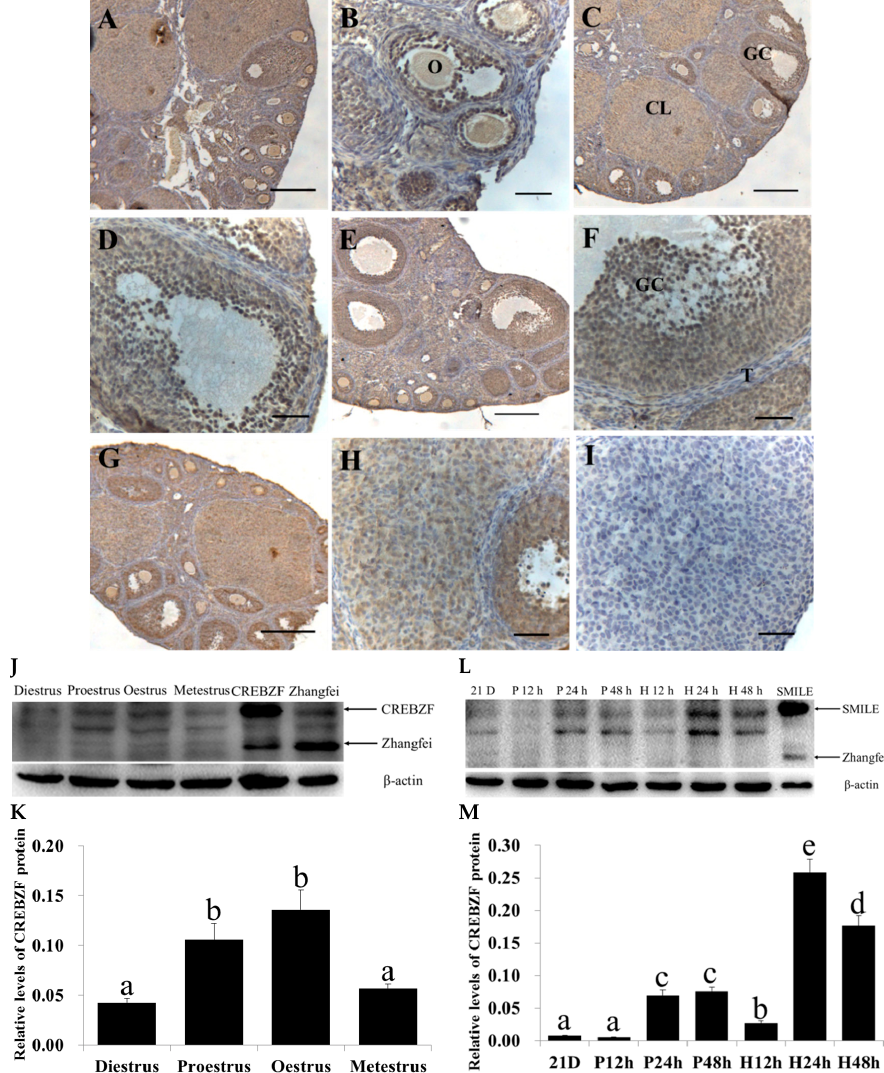
Figure 1. Localization and expression of CREBZF protein in the mouse ovaries during the estrous cycle. ( A , B ) Diestrus; ( C , D ) proestrus; ( E , F ) oestrus; ( G , H ) metestrus; ( I ) Negative control. Positive immunostaining for CREBZF is indicated by a brown reaction product. GC, granulosa cells; O, oocyte; T, theca cells; CL, corpus luteum. Scale bars, 100 μ m ( A , C , E , G ) and 50 μ m ( B , D , F , H , I ). ( J , K ) Protein levels of SMILE and Zhangfei in the ovary during the estrous cycle; ( L , M ) protein levels of SMILE and Zhangfei in the ovary after treatment with pregnant mare serum gonadotropin (PMSG) or human chorionic gonadotropin (hCG); 21 D, 21-day-old; P12h, P24h, and P48h, treated with PMSG for 12, 24 and 48 h, respectively; H12h, H24h, and H48h, after treatment with PMSG for 48 h and hCG for 12, 24 and 48 h, respectively. Analyses of the band intensity on films are presented as the relative ratio of SMILE or Zhangfei to β -actin. Statistical analysis is shown in the bar graphs. Data are presented as the mean ± SEM. The bars with different letters indicate significant differences ( p < 0.05), while the bars with the same letter indicate no difference between their respective